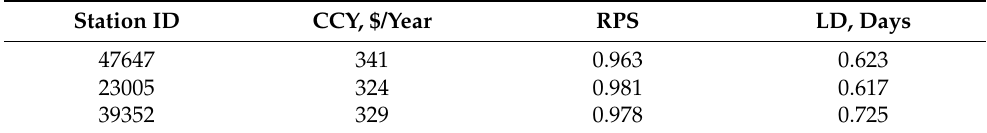
Table 5. Characteristics of configuration.